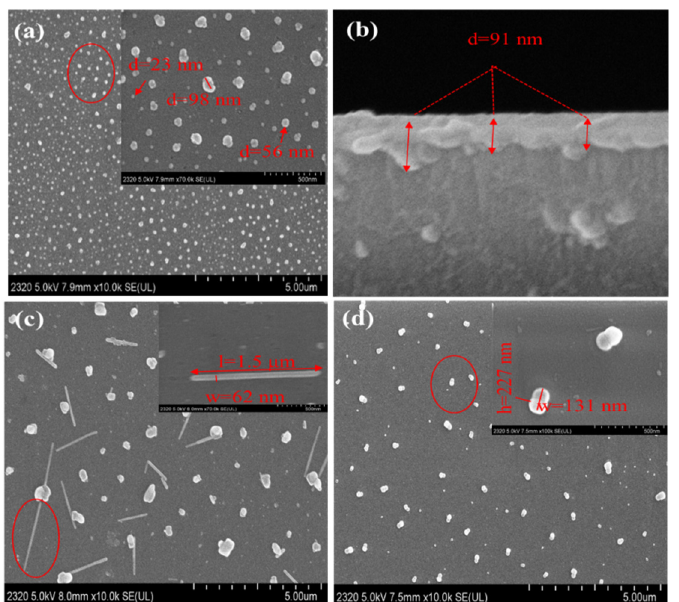
Figure 10. SEM images of PPc film. Before gas exposure: ( a ) surface view and ( b ) cross-section view. After gas exposure: ( c ) HCl and ( d ) styrene.